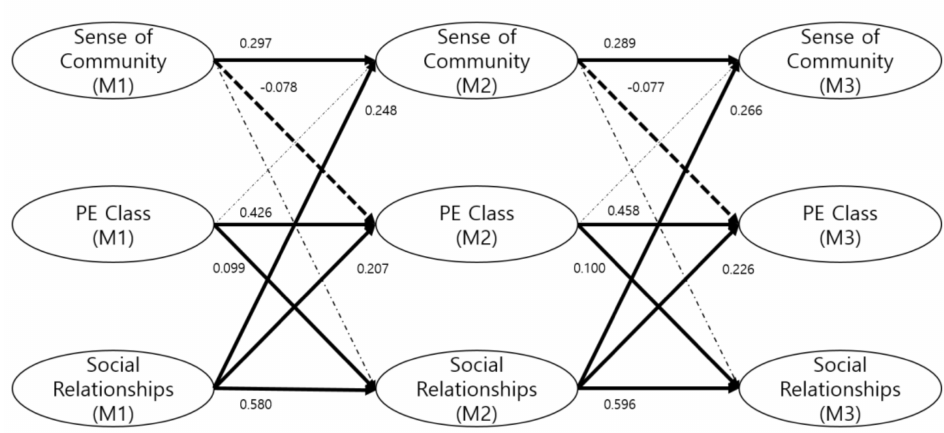
Figure 2. Results of the research